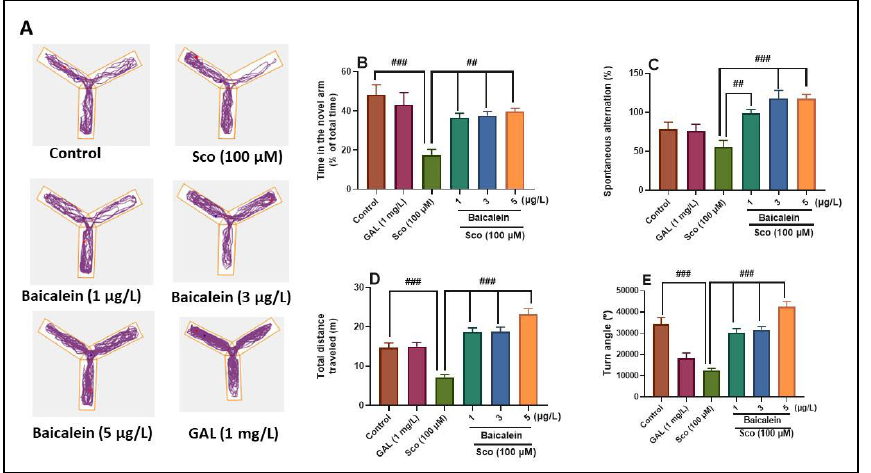
Figure 2. Effects of the baicalein 5,6-dimethyl ether (1, 3, and 5 µg/L) on scopolamine (Sco, 100 μM)-induced increasing of the exploratory behavior and locomotion in the Y-maze. ( A ) representative swimming tracks of zebrafish in each group; ( B ) time in the novel arm (% of the total time) in each group; ( C ) spontaneous alternation (%) in each group; ( D ) total distance travelled (m) in each group; ( E ) turn angle (°) in each group. Values are means ± S.E.M. ( n = 10). For Tukey’s post hoc analyses: Control vs. Sco: ### p < 0.0001, and ## p < 0.001, Sco vs. Baicalein 5,6-dimethyl ether (1, 3, and 5 µg/L): ## p < 0.001, and ### p < 0.0001 (B, C, D, and E).